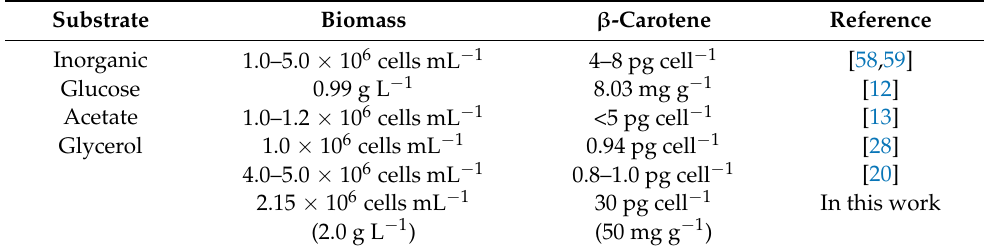
Table 5. Biomass and β -carotene of D . salina grown with various carbon substrates reported by the literature and in this